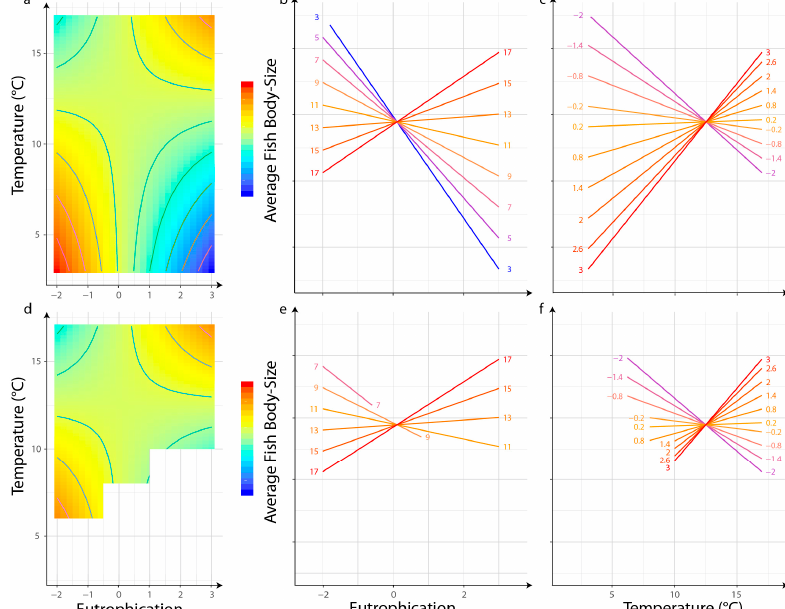
Figure 3. Effect of interaction between average temperature and eutrophication level on Average Fish Body Size when considering all possible combinations of pressures ( a – c ), or when considering only the observed combination of pressures (see Figure 1) ( d – f ). ( a , d ) Low theoretical values are in blue and high theoretical values in red.